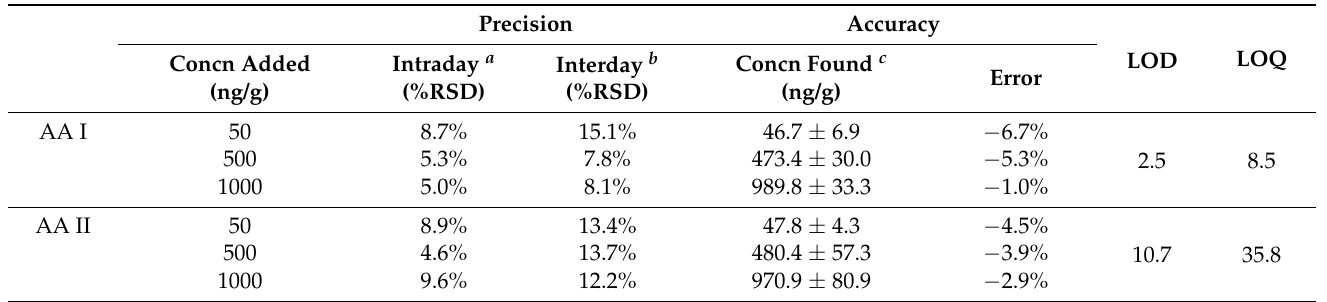
Table 1. Limits of detection, intra- and inter-day precision, and accuracy of the developed HPLC- MS/MS method for the determination of AA I and AA II in lettuce. Precision Accuracy